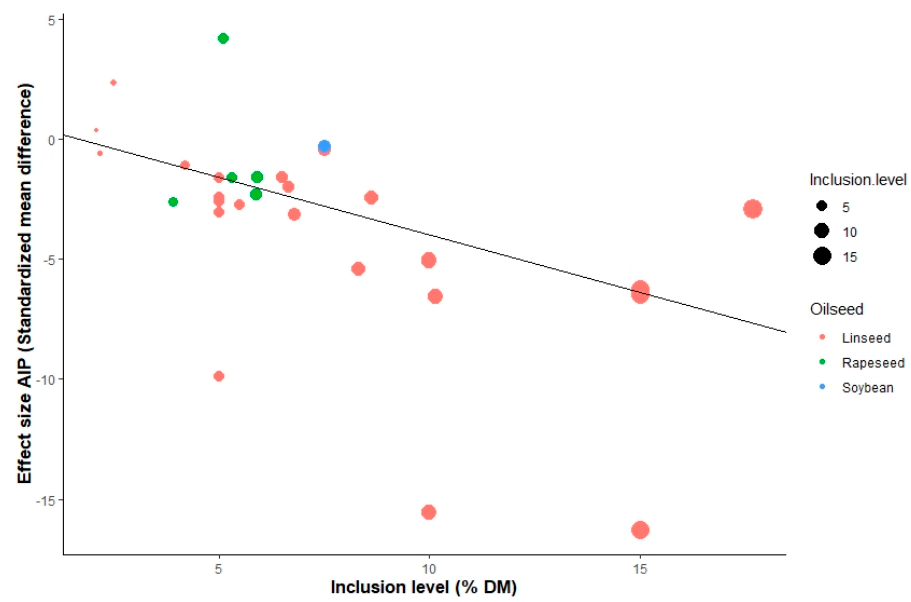
Figure 7. Bubble plot of AI of the raw mean difference. Inclusion level of oilseeds is represented by the size of the point with the value to the left (%); the color of the point indicates the type of oilseed.